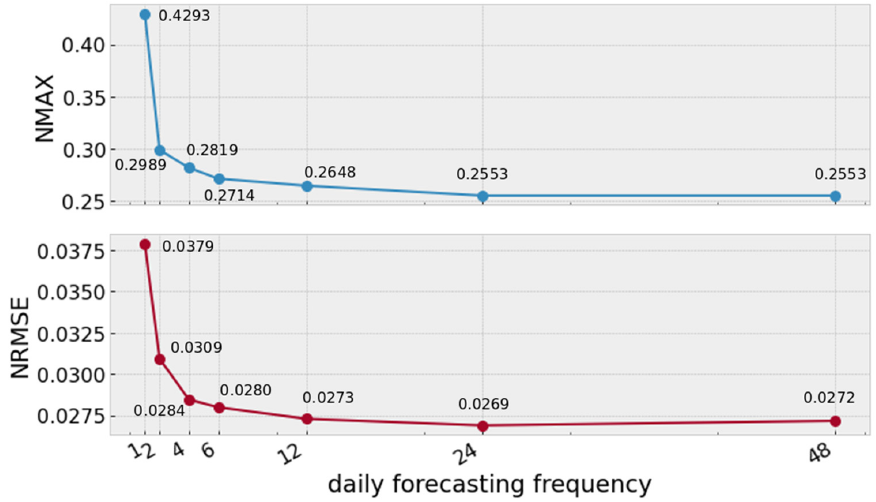
Figure 7. Error metrics on GEPP for different values of daily forecasting frequency in Scenario 3.